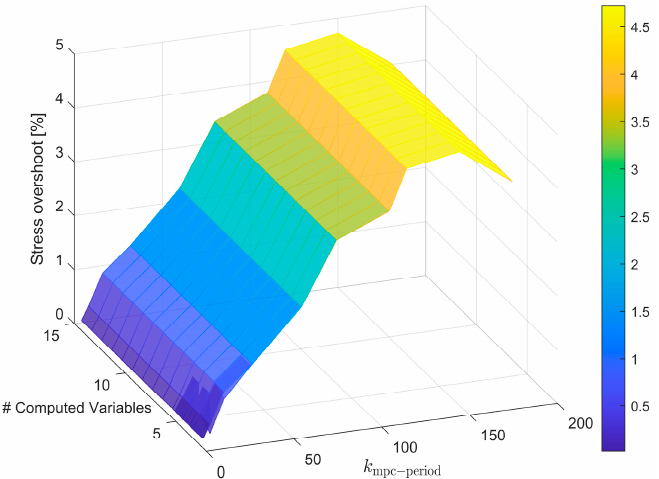
Figure 15. DoE with variable 𝑁 (cid:3051) , 𝑁 (cid:3043)(cid:3045)(cid:3032)(cid:3031) , 𝑘 mpc-period : stress overshoot in function of the parameters.